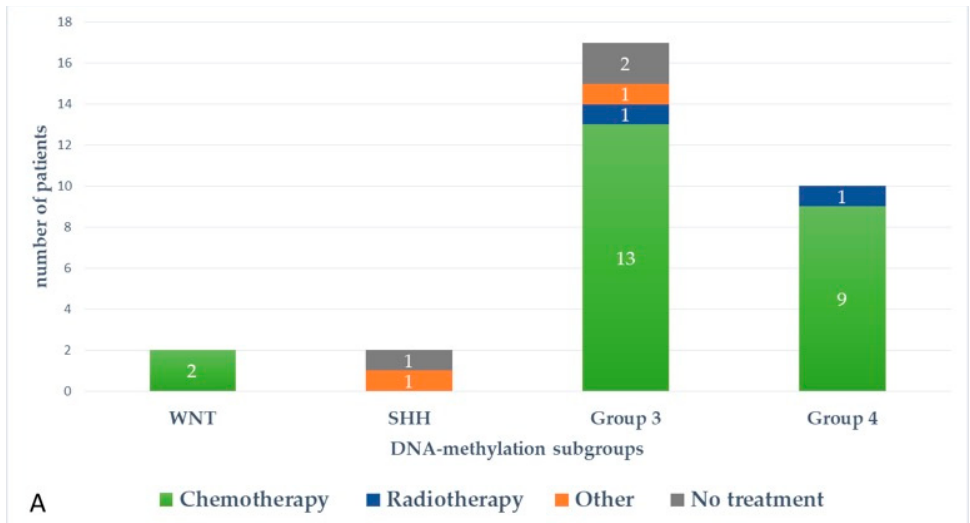
Figure 5. Upfront treatment according to DNA-methylation subgroups in patients with relapsed medulloblastoma.